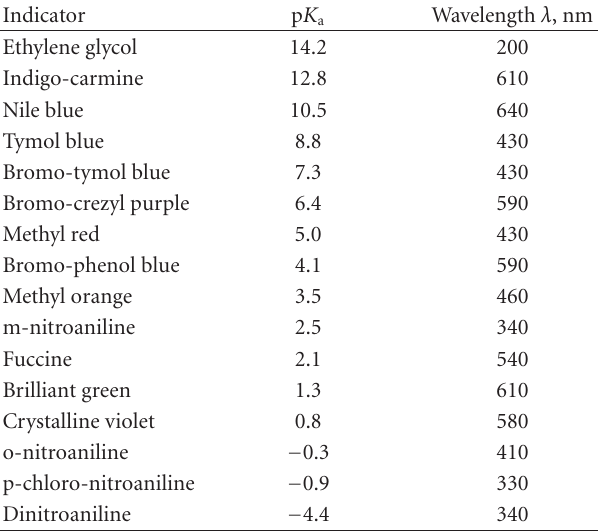
Table 1: Acid-base indicators and their